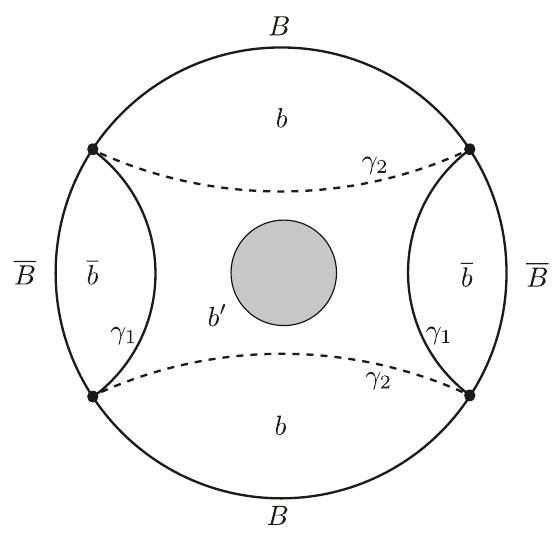
Figure 1 . Setup in which we derive a contradiction from a naïve application of the QES prescrip- tion. The boundary is divided into two subregions, B and B . For both, there are two competing quantum extremal surfaces, γ larger, such that the area of γ amount of matter (the “dustball”), such that some states of the matter have entropy much larger than the difference in areas of the two